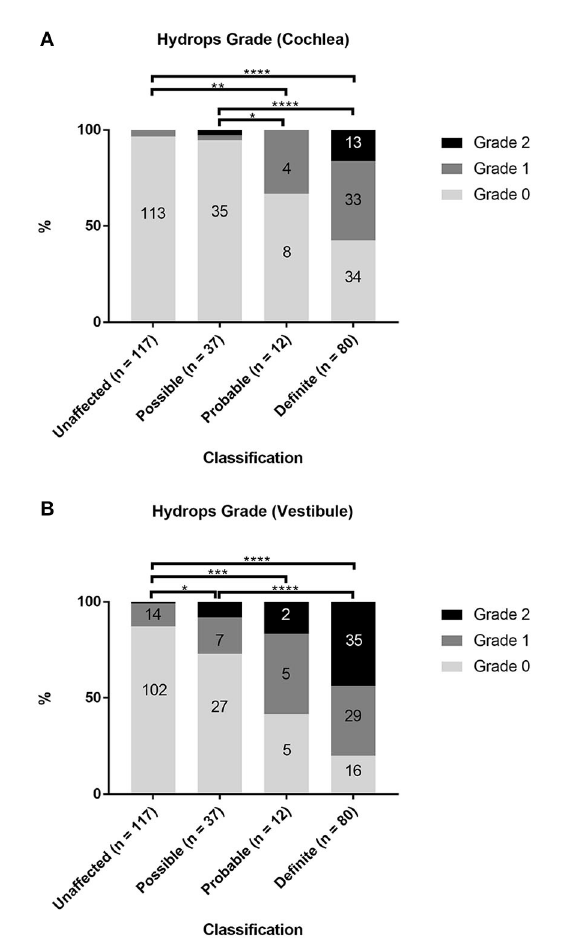
FIGURE2 Comparison of hydrops grade according to the diagnosis of Ménière’s disease (MD). The proportions of hydrops grades 0, 1, and 2 in unaffected ears and in ears with possible, probable, or definite MD were evaluated separately in the cochlea (A) and vestibule (B) . Fisher’s exact test with pairwise Fisher’s exact tests as post-hoc analysis. * p < 0.05; ** p < 0.01; *** p < 0.001; **** p <